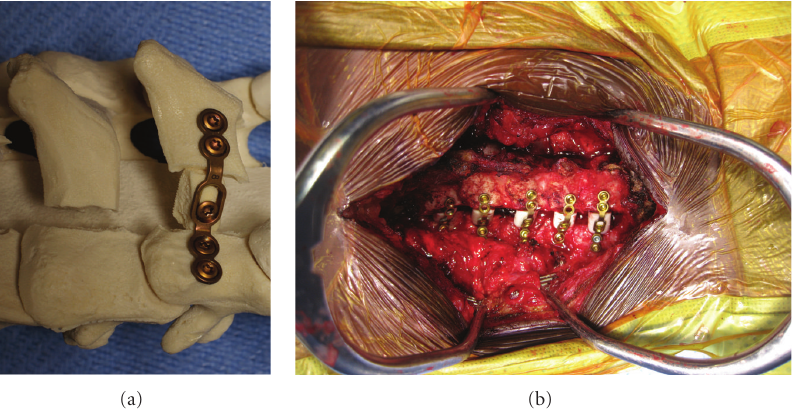
Figure 7: Sawbones model (a) and intraoperative photo (b) showing miniplate and allograft placed in the laminar opening. The miniplate has been fixed with 2 screws on both the laminar and lateral mass side.